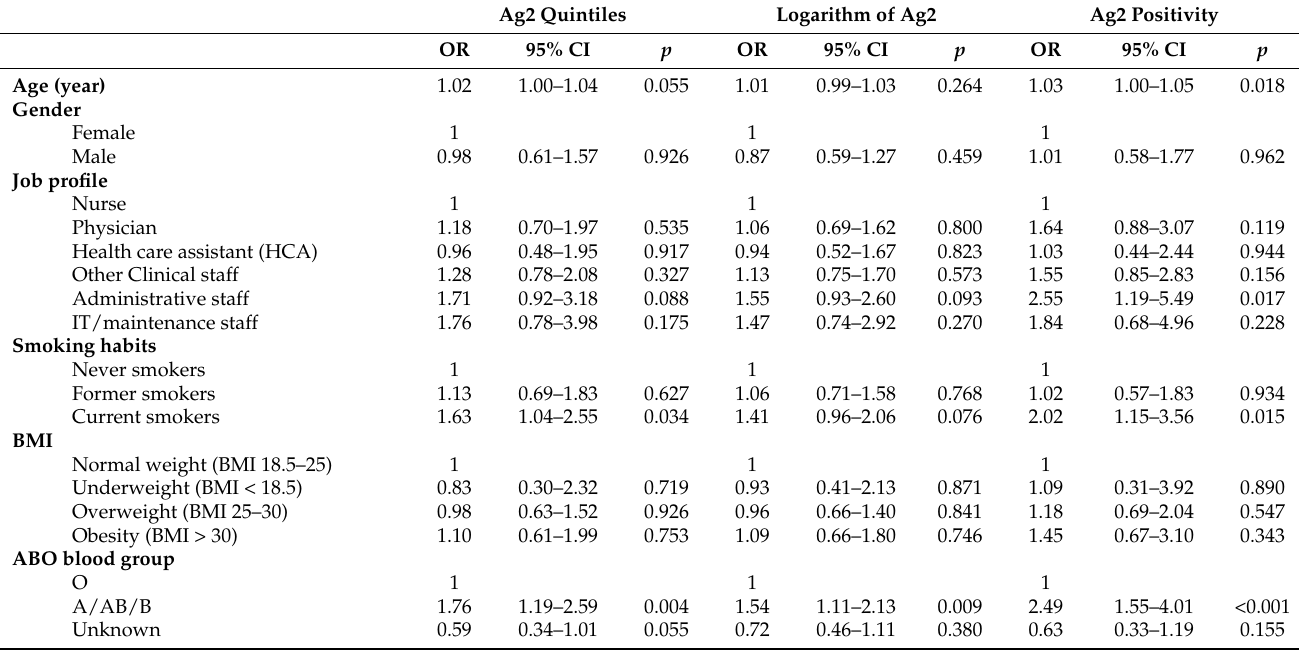
Table 4. Multivariable analyses (ORs and 95% CI) for the predictors of Ag2 cellular response among 419 vaccinated HCW of CSS, using different outcomes: quintiles of Ag2 (low vs. high, ordinal